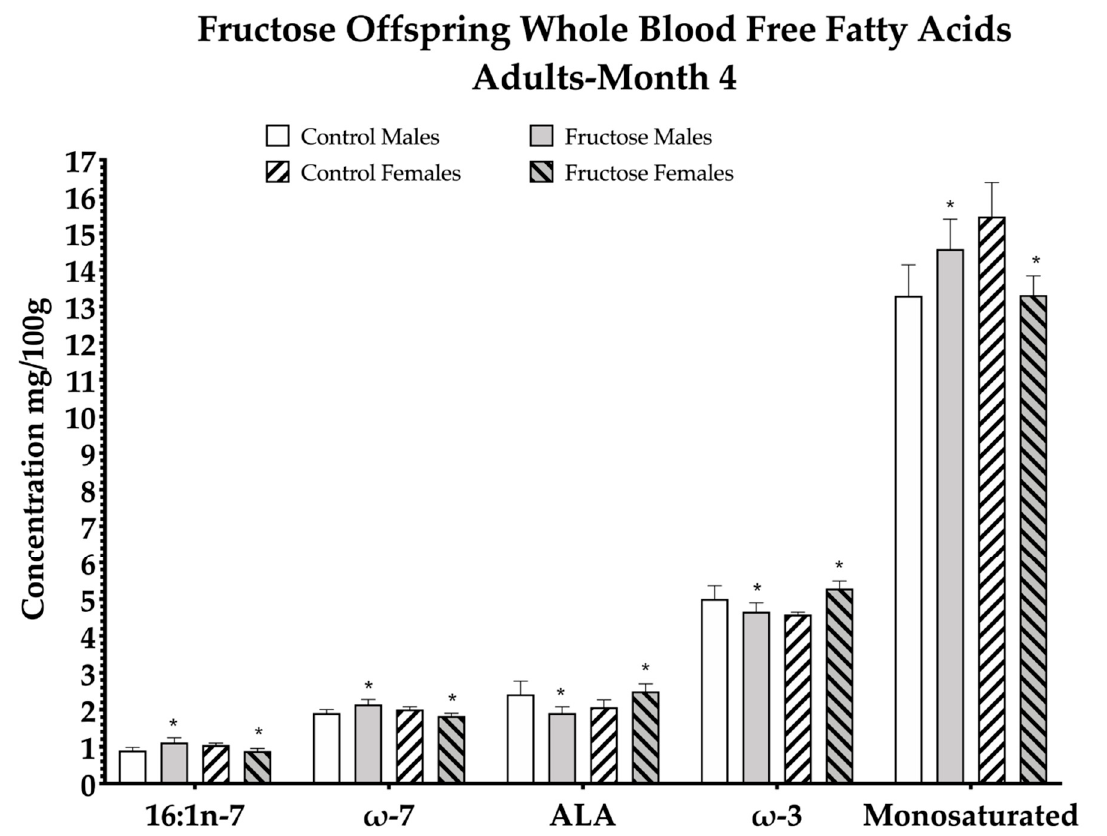
Figure 2. Free fatty acid (FFA) concentrations in the blood of adult (4M) offspring. CD males ( n = 7); FD males ( n = 9); CD females ( n = 7) and FD females ( n = 6). Figure represents offspring month 4 whole blood FFA. Palmitoleic acid (16:1n-7), total omega-7 ( ω -7), alpha linolenic acid (ALA), total omega-3 ( ω -7). All data were analysed using a 2 × 2 factorial design with diet*sex*interaction included as factors (general analysis of variance) using IBM SPSS statistics 25. Data presented as group mean ± SEM. * denotes significance of p < 0.05. Table 2. Free fatty acid concentrations in fructose adult offspring whole blood at month 4.